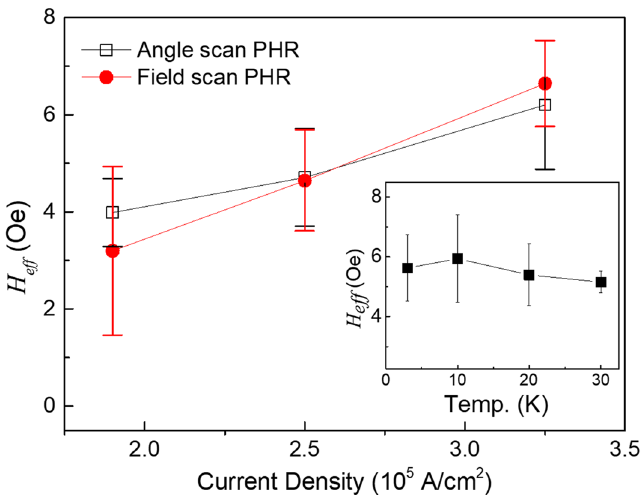
H Hin H Assi and , respectively. Solid lines show fitting results obtained with Eqs. (7) SW SW (cid:31) (cid:31) (cid:31) (cid:31) (cid:31) (cid:31) (cid:31) (cid:31)